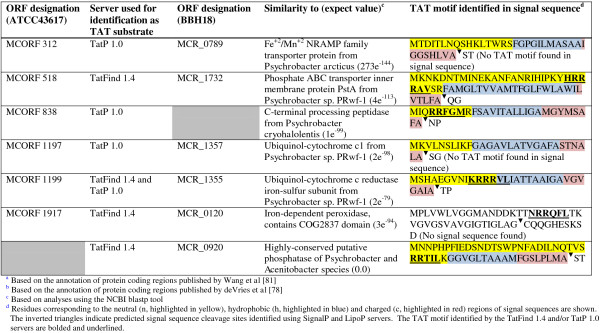
Comparison of the putative TAT substrates identified in the genomes of M. catarrhalis strains ATCC43617a and BBH18b.